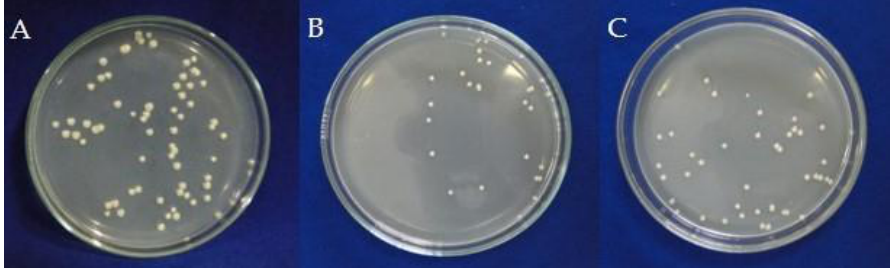
Figure 2. Effect of small-scale extracts of NF17 and NFrCs16 fungi from Morinda citrifolia on the growth of Xanthomonas axonopodis pv. passiflorae . ( A ): Control; ( B ): NF17 extract; ( C ): NFrCs16